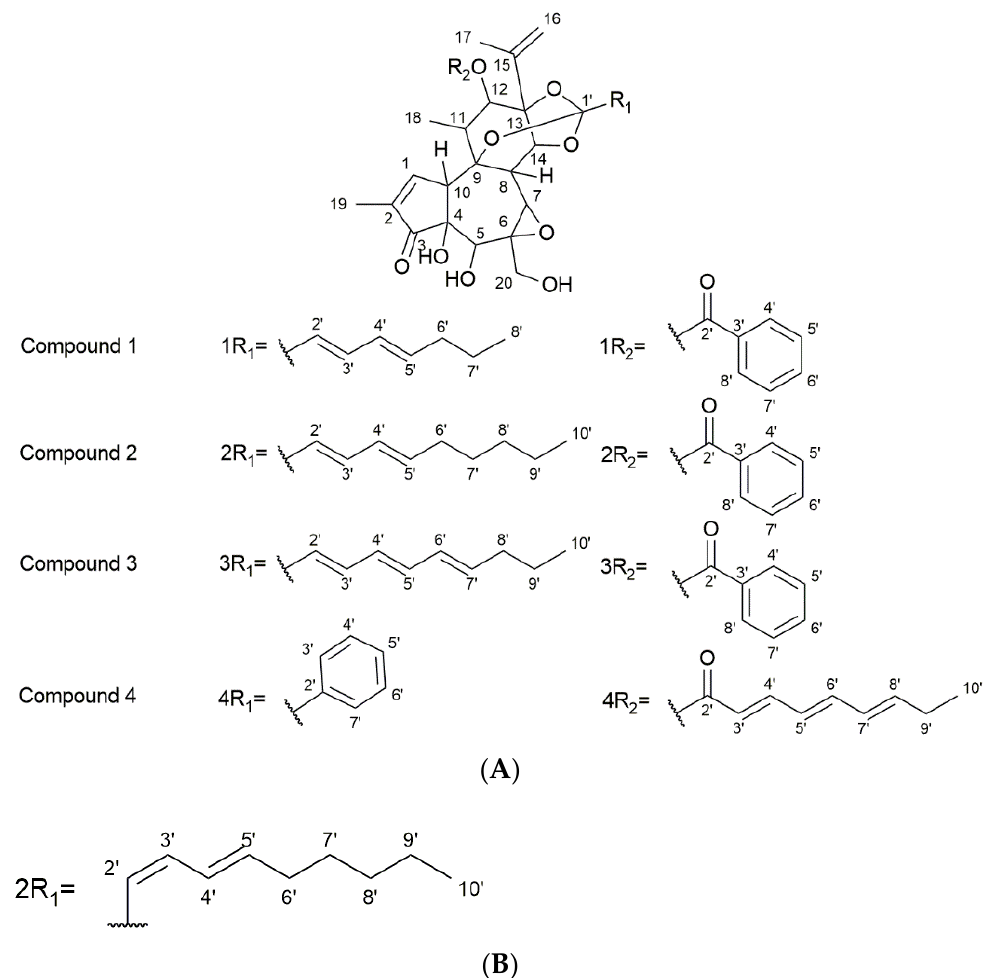
Figure 3. ( A ) Structures of the isolated compounds. ( B ) Proposed R 1 fragment of the second compound present with compound 2 (isomer present as part of Yuanhuacine mixture). Table 1. 1 H and 13 C NMR Spectroscopic Data for compounds 1 , 2 , 3 and 4 (CDCl 3 , 500 MHz).